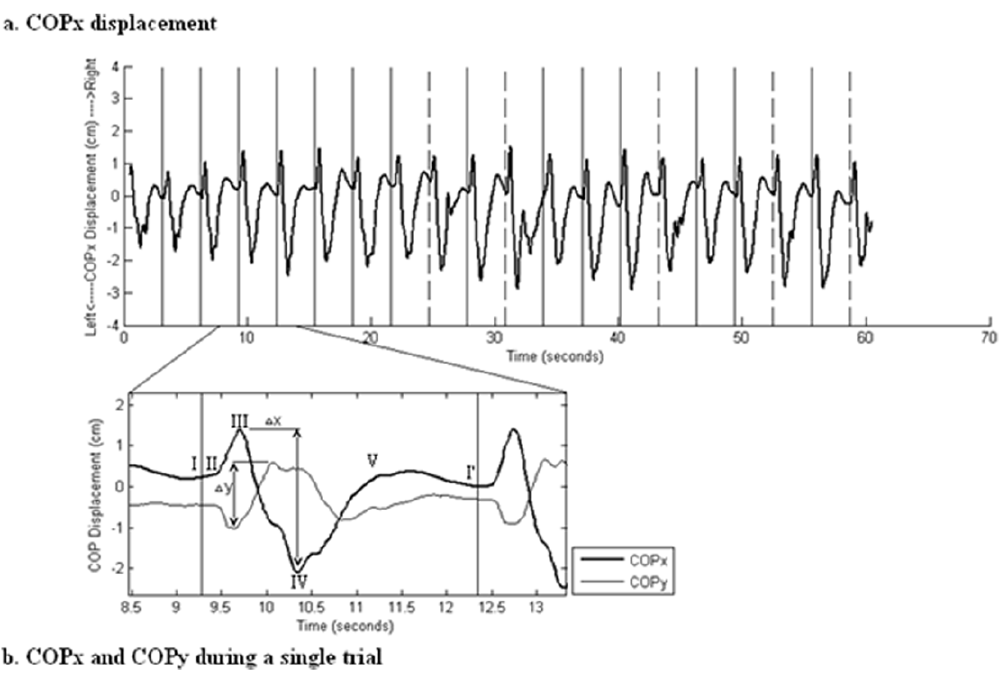
Figure 3. COP displacement during a block and a single trial. a) Representative results of COPx displacement during a block. Vertical solid lines represent the ‘start’ event of a successful trial. Vertical dashed lines represent the ‘start’ event of an unsuccessful trial. b) Detailed examination of the COPx (medio-lateral) and COPy (anterior-posterior) sway movements displacements during a trial (positive values are right and backward displacement of the COPx and COPy, respectively): (I) the ‘start’ cue, (II) as the hand moves toward the first target the COP starts to travel to the right and toward the screen, (III) as the hand starts to move toward target 2 the COP stops traveling to the right and forward and begins its shift backward and left, (IV) as the hand touches targets 2 and 3 and moves toward target 4, the COP stops traveling backward and left and turns again to forward and right, (V) the trial ends as the hand returns to its original location and the body posture is stabilized; (I 9 ) the beginning of the next trial. D x and D y are the absolute difference between the extreme values in each of the COP axes within a given trial; SD D x and SD D y are the standard deviations of all successful trials D x and D y within a block, respectively.